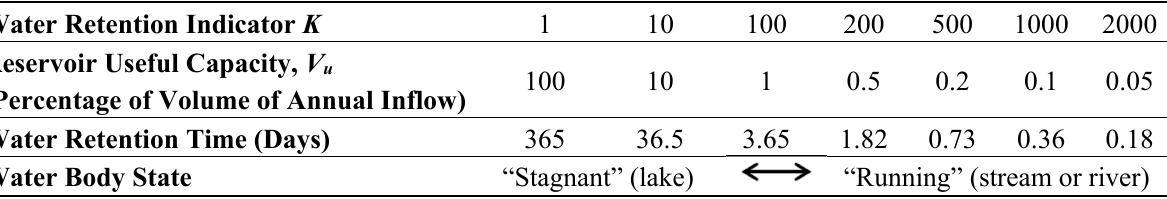
Table 2. Water retention